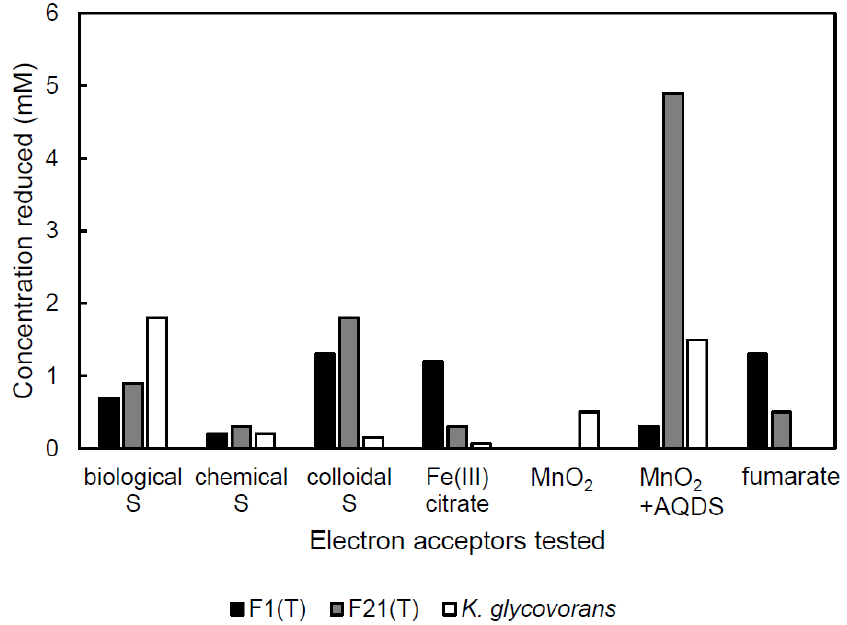
Figure 2. Concentration of external electron acceptor reduced during growth on sugars. Abbreviations: S, elemental sulfur; Fe(III), ferric iron; MnO 2 , manganese oxide; AQDS,